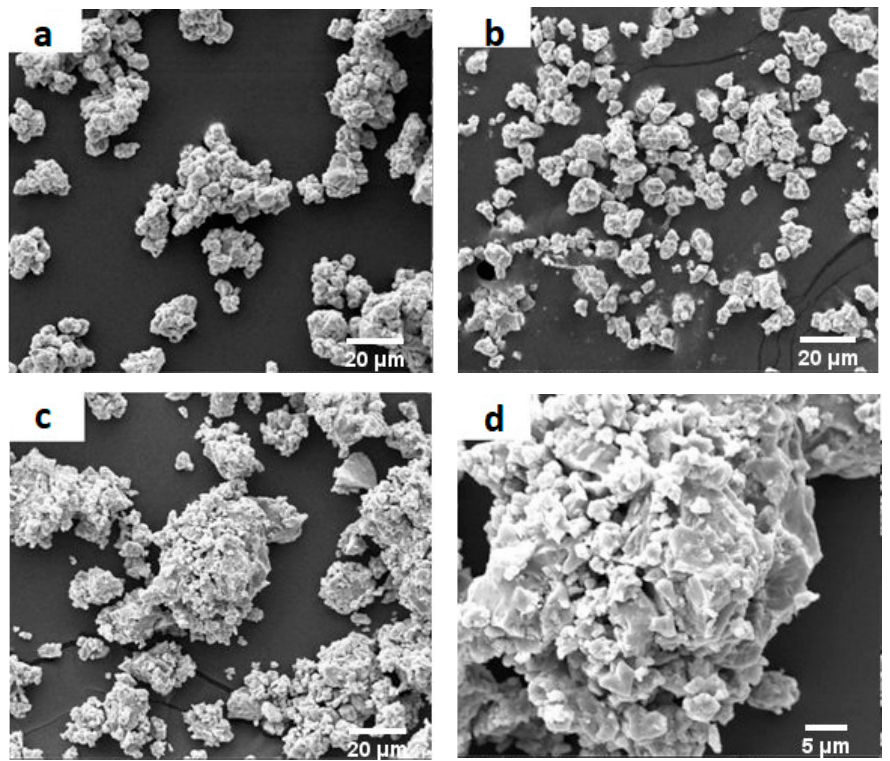
Figure 9. SEM images of the ( a ) TiFe, ( b ) Fe20 ( c ) Ti20, and ( d ) Ti20 (using a higher magnification) milled products after 40 h of milling.